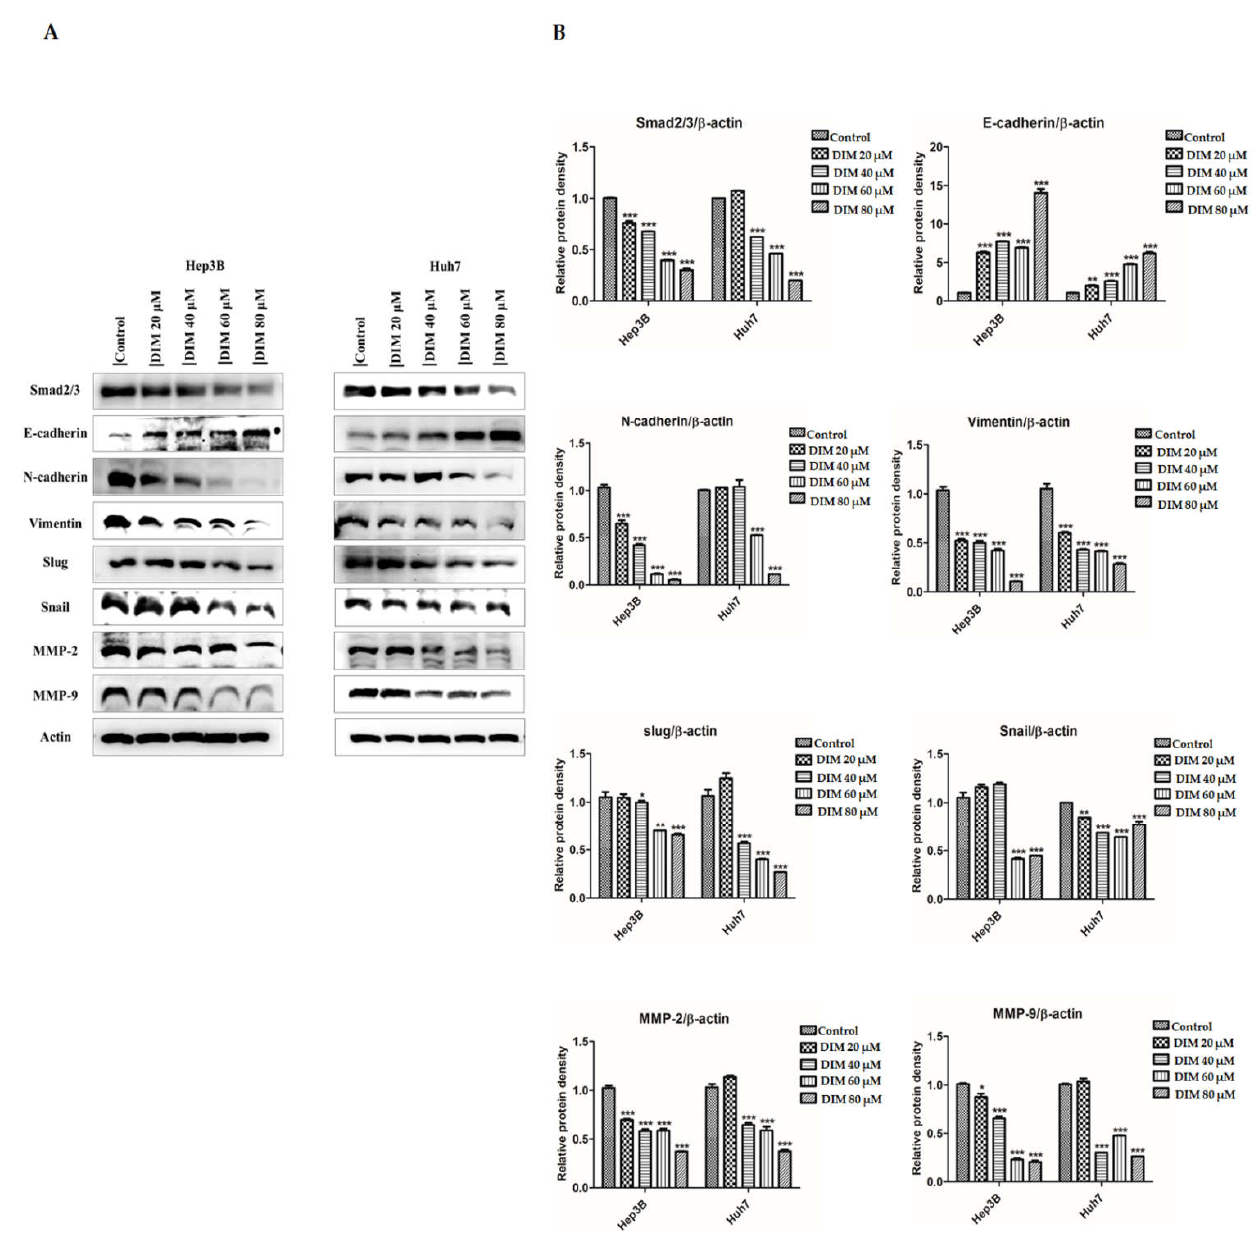
Figure 7. DIM inhibits EMT regulatory proteins in HCC cell lines: ( A ) Anti-cancer effects of DIM on the expression of epithelial–mesenchymal transition (EMT) related protein after 24 h treatment as determined by Western blot analysis. ( B ) Quantification of relative protein expression normalized to β-actin. Provided data represents the mean ± SE of three independent experiments. *, p < 0.05; **, p < 0.01; and ***, p < 0.001 denote significant variation compared to the control group.